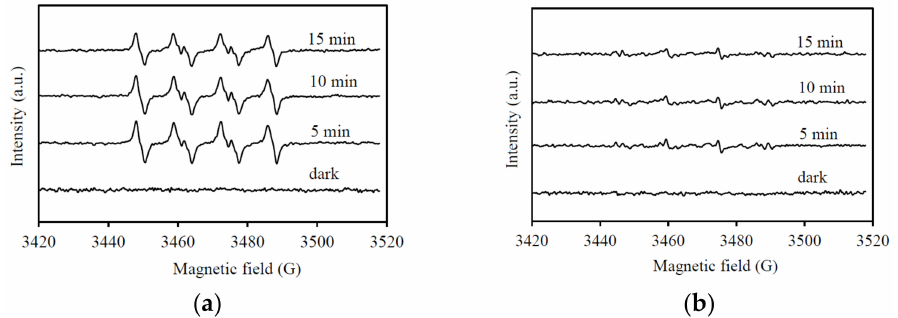
Figure 9. DMPO spin-trapping EPR spectra for ( a ) DMPO-O 2 − and ( b ) DMPO-OH under visible light irradiation with SnIn 4 S 8 catalyst.